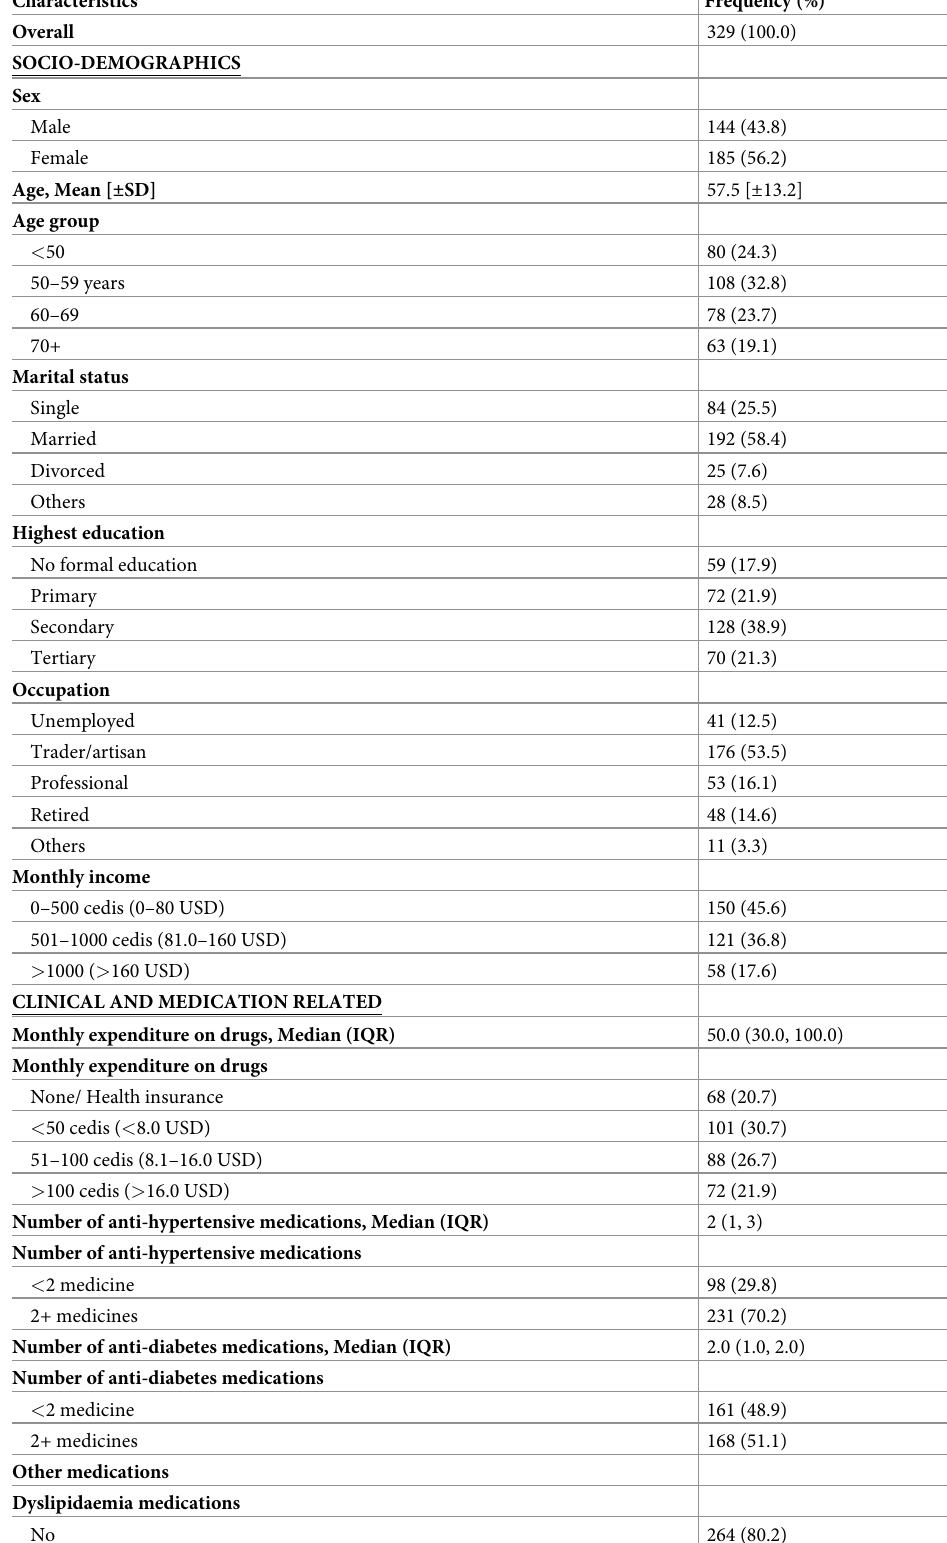
Table 1. Background characteristics of study participants (N =